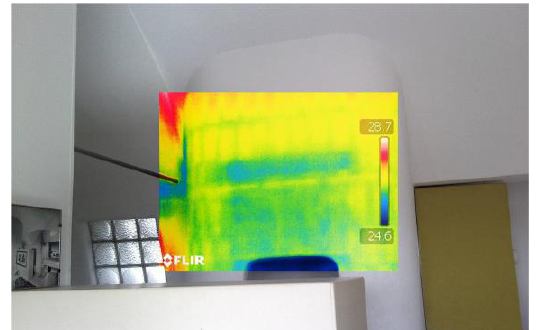
Figure 5. © A-BIME: Infrared camera picture: structure of the shower